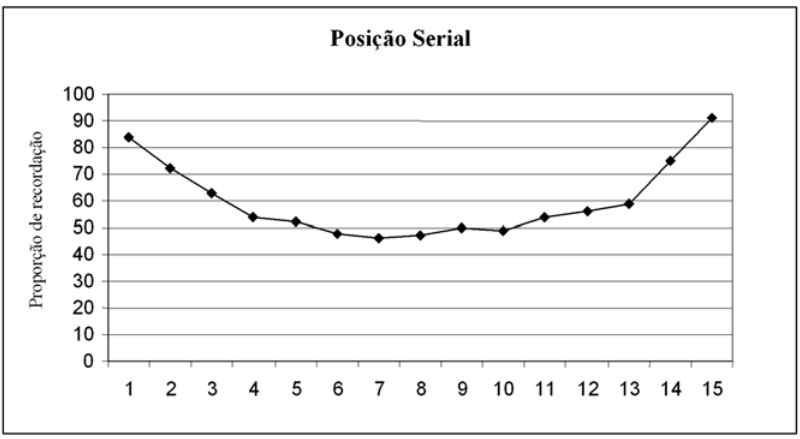
Figura 1 . Proporção de recordações verdadeiras em função da posição serial dos